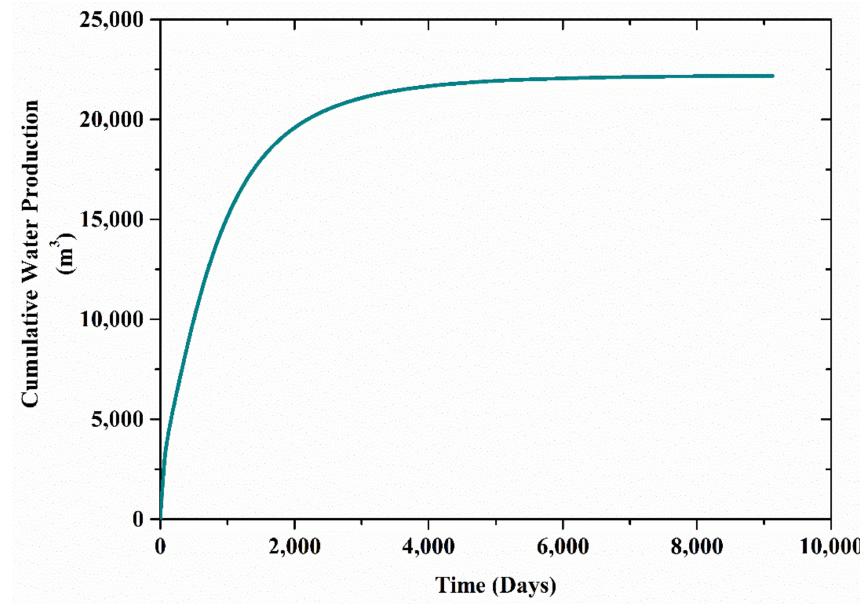
Figure 7. Cumulative water production vs. time.